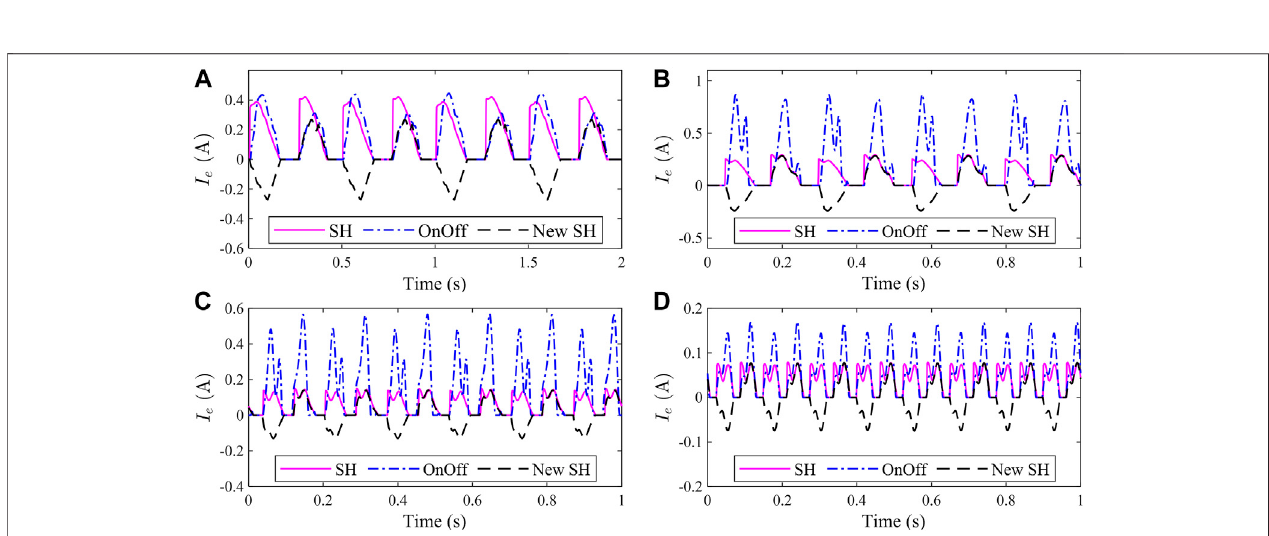
FIGURE 12 | Expected current of the MR damper: (A) 2 Hz, (B) 4 Hz, (C) 6 Hz, and (D) 8 Hz